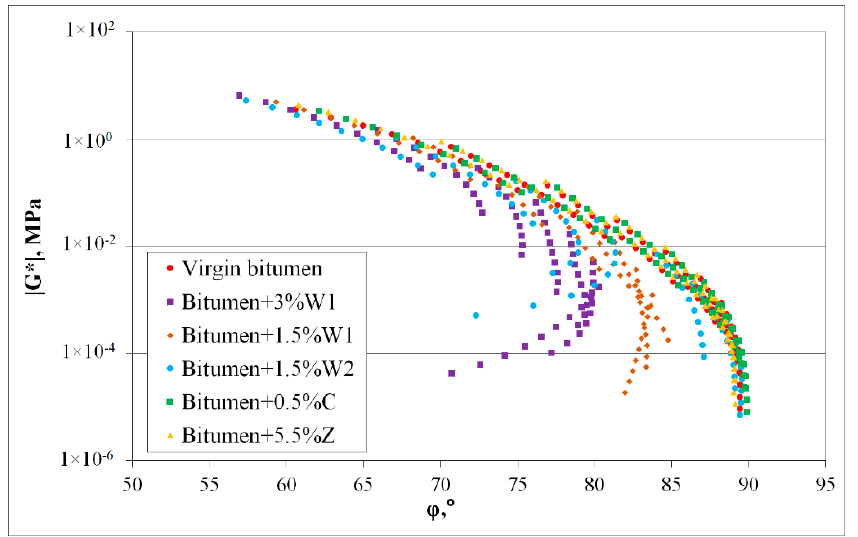
Figure 5. Variations of complex shear modulus with phase angle (Black diagram) for 50/70 virgin bitumen and bitumen blends containing additives.